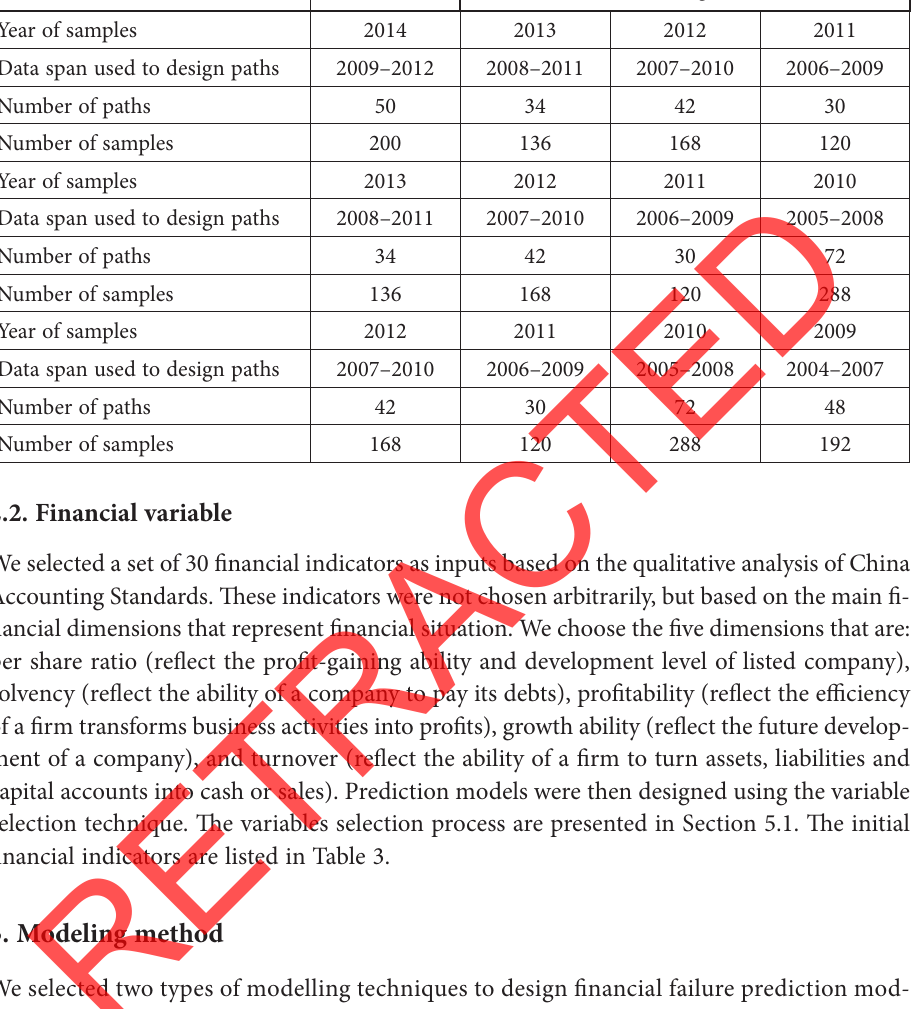
Table 2. Training samples and test samples Test set Training